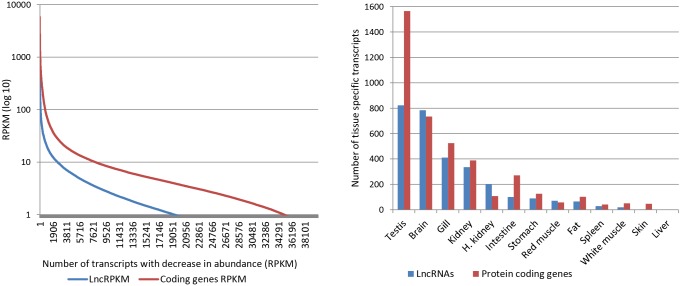
RPKM comparison of protein-coding genes and lncRNAs.Transcript abundance of lncRNAs is lower than that of protein-coding genes. Average RPKM of the most abundant 40,000 genes is 15.69 and 3.49 for protein coding genes and LncRNAs, respectively (Left). Number of tissue-specific lncRNAs and protein-coding genes in various tissues. Expression of lncRNAs and protein-coding genes showed similar patterns among different tissues (Right).